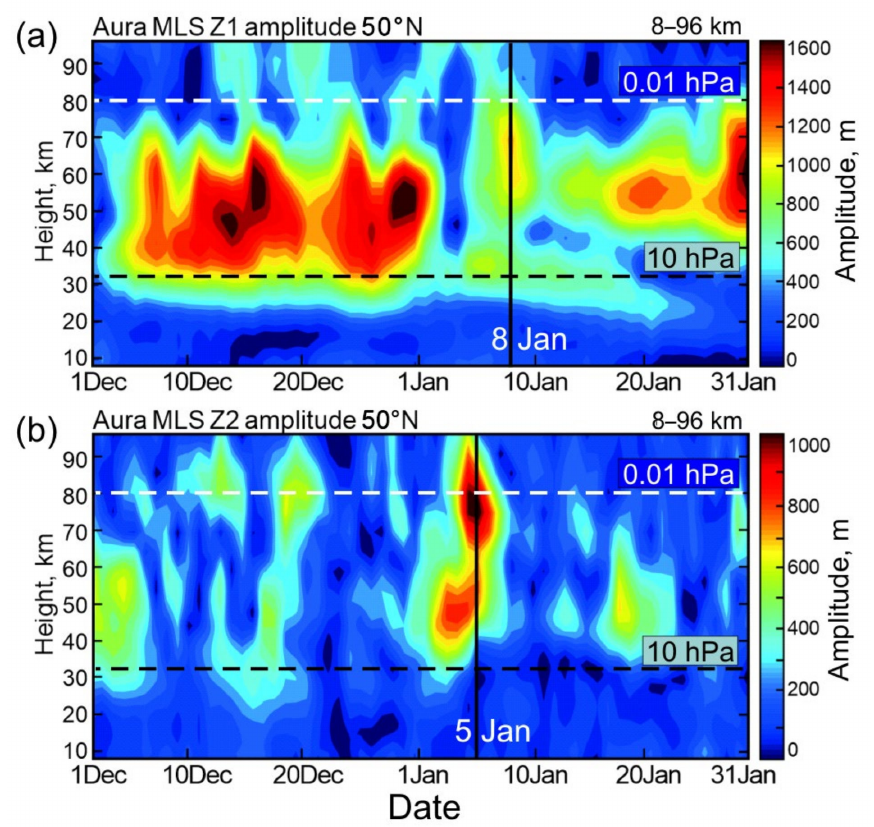
Figure 4. The amplitudes ( a ) Z1 and ( b ) Z2 at 50 ◦ N in time–altitude section for December 2020– January 2021. Vertical lines indicate the mesospheric wave amplification with wave 1 lagging wave 2 by 3